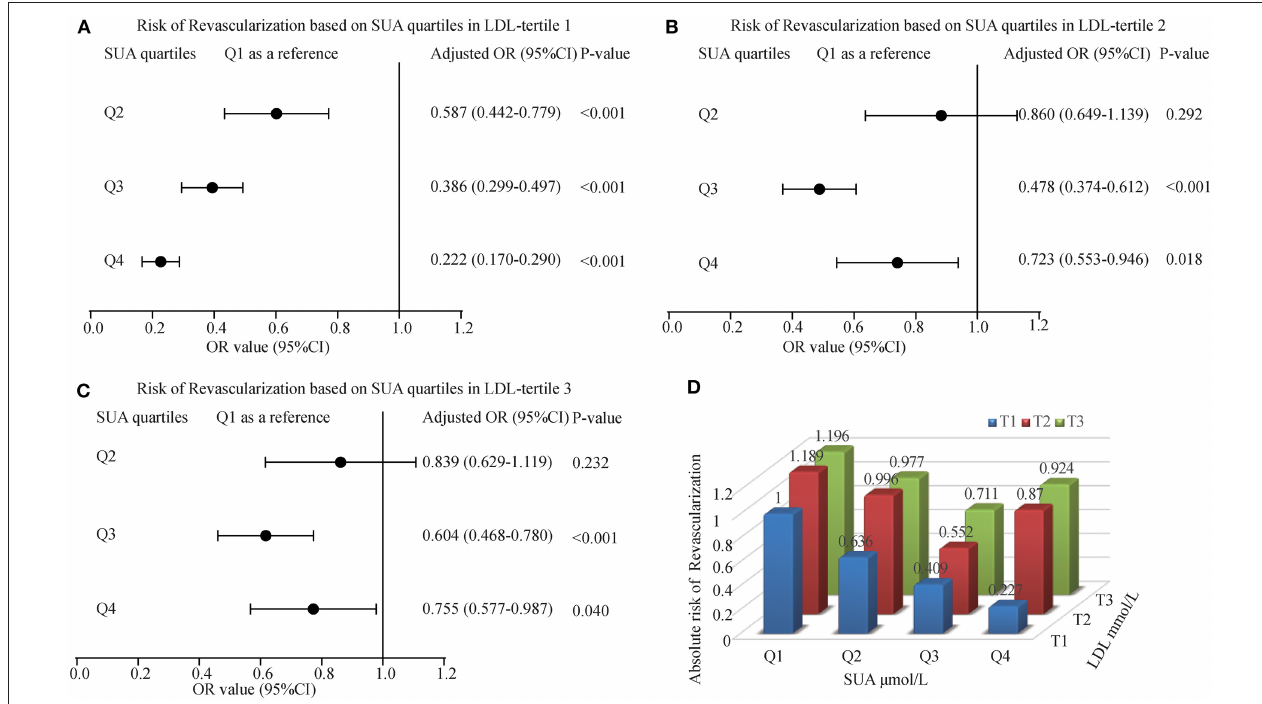
FIGURE 3 | The risk of myocardial revascularization (MRT) based on baseline SUA quartiles in ACS patients. ( A ) Adjusted odd ratios for MRT in LDL-tertile 1; ( B ) Adjusted odd ratios for MRT in LDL-tertile 2; ( C ) Adjusted odd ratios for MRT in LDL-tertile 3; ( D ) Adjusted odd ratios for MRT in each group by quartiles of the SUA and tertiles of the LDL. Adjusted for age, gender, smoking, HDL, TG, Glucose, Creatinine, Statin use, and Hypertension.